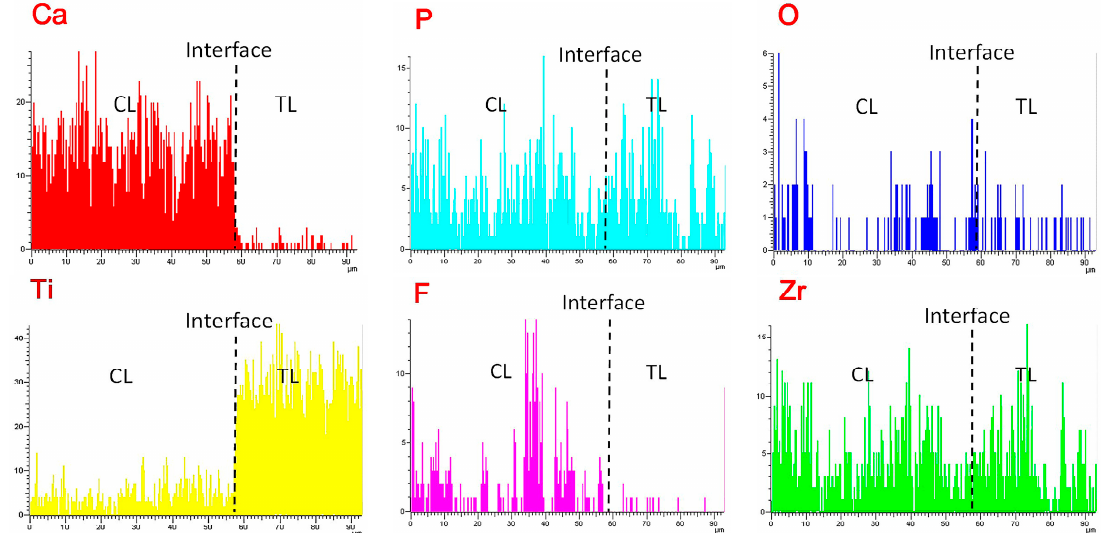
Figure 9. EDS line scan results for Ca, P, O, Ti, F and Zr contents of CL and TL in FA/ZrO 2 specimen prepared using P = 1200 W and V = 600 mm/min.